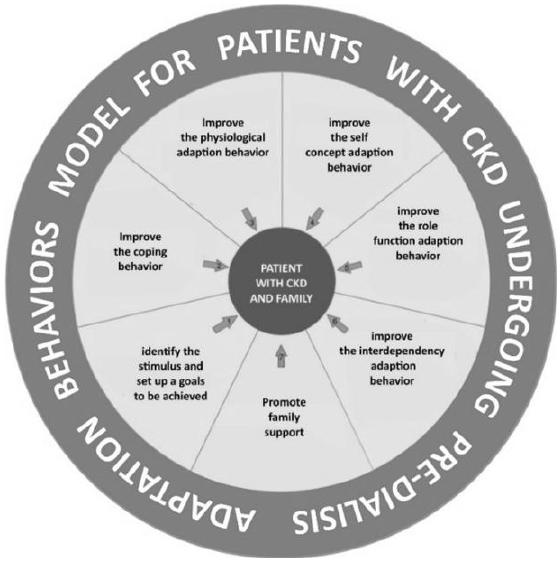
Figure 1. The developed Roy’s adaptation behavior model for patients with CKD undergoing